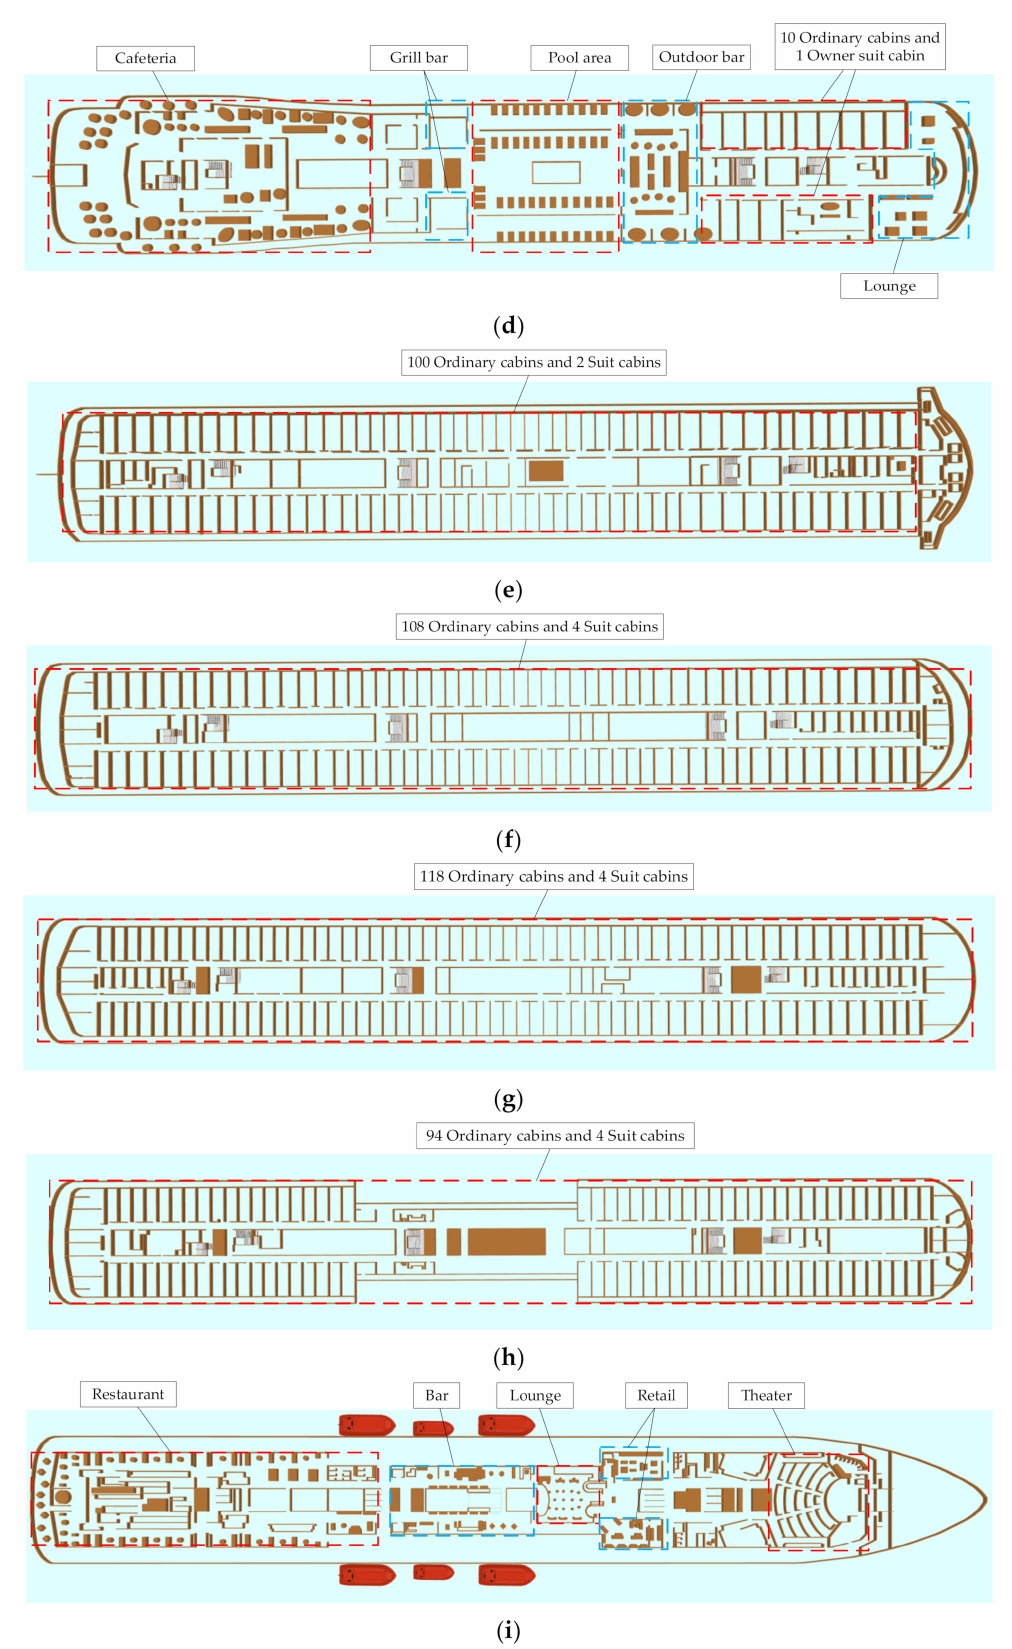
Figure A13. Cont